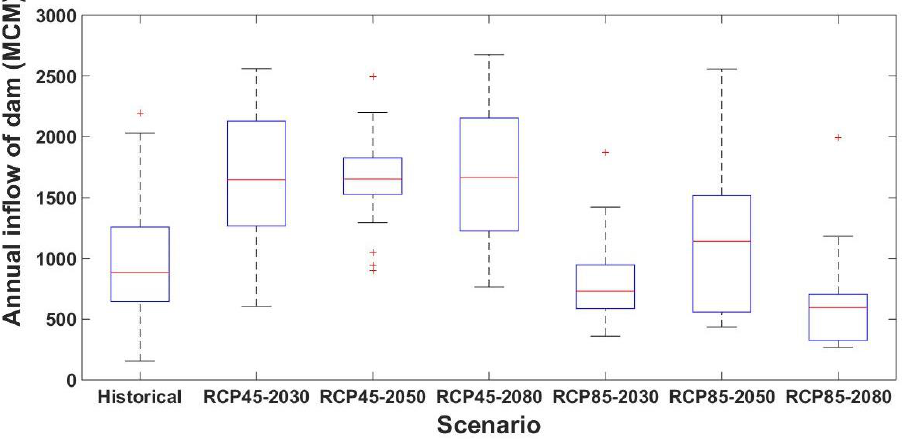
Figure 6. Box (whisker) plots of the historical and future predicted annual Boukan Dam inflows.